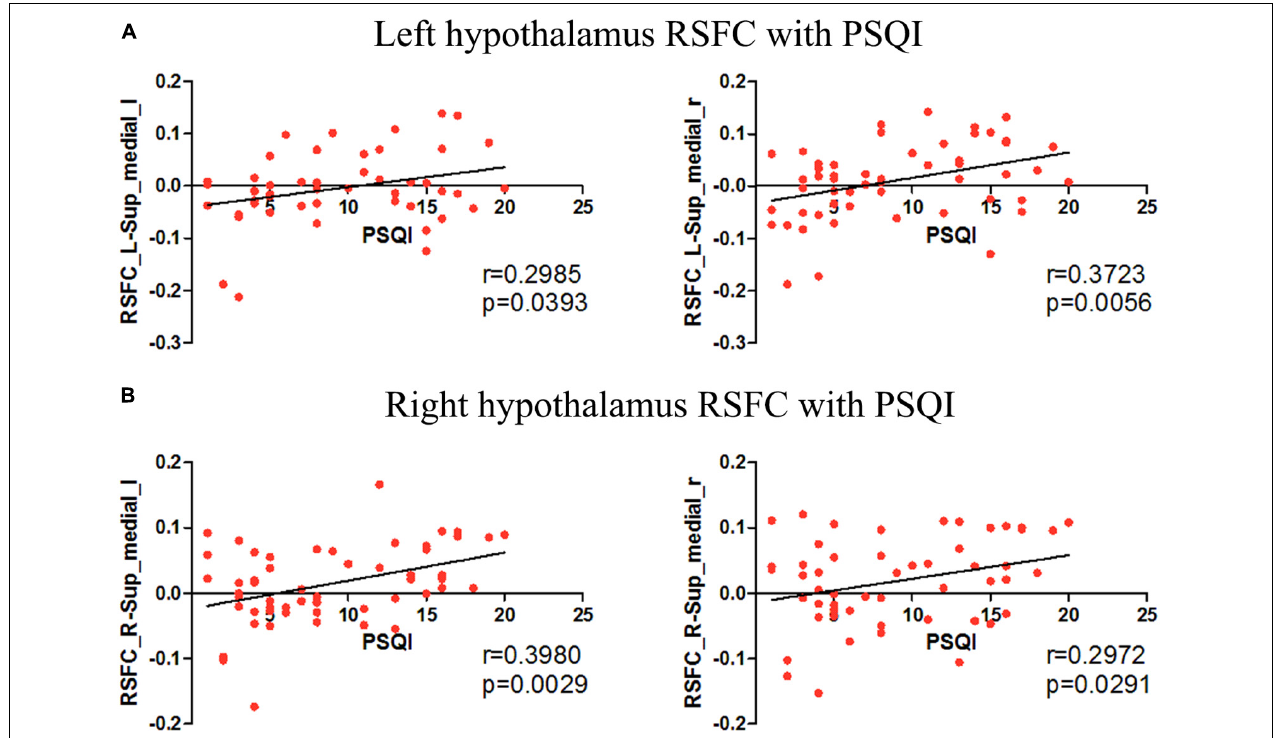
FIGURE 2 | The correlation between the hypothalamus RSFC and PSQI. (A) Correlations were observed between the left hypothalamus-bilateral mPFC RSFC and PSQI scores. (B) Correlations were observed between the right hypothalamus-bilateral mPFC RSFC and PSQI